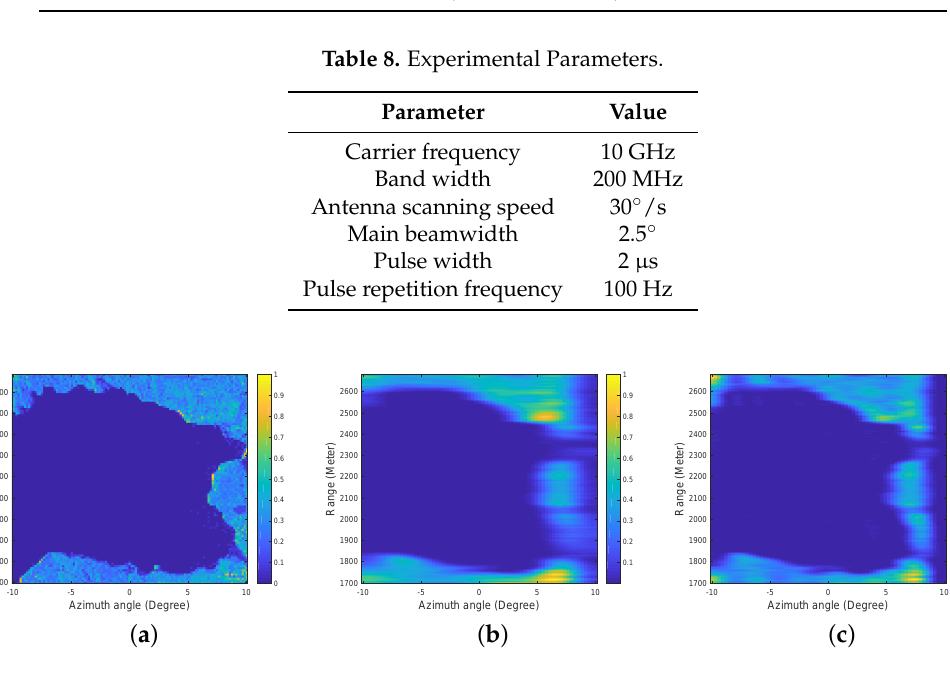
Figure 11. The simulation results when TV and FTV have the same running time. ( a ) The simulation scenario; ( b ) The TV method, t = 55.37 s; ( c ) The FTV method, t = 55.37